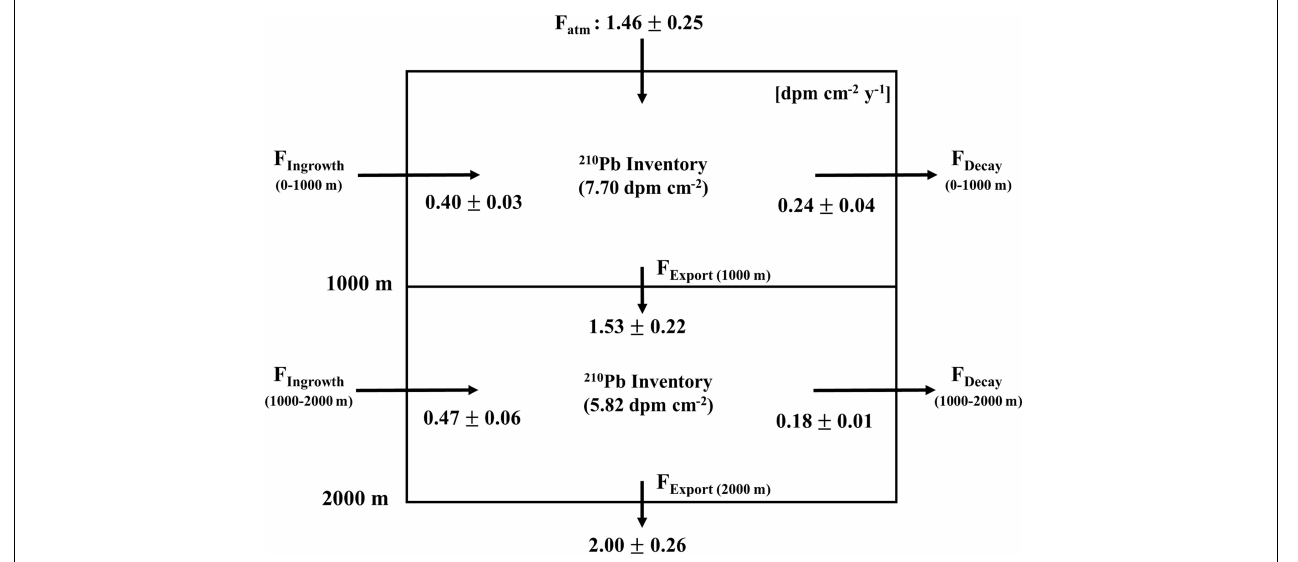
FIGURE 4 | A schematic box model accounting for the ingrowth, decay, export, and atmospheric flux of 210 Pb in the East Sea (dpm cm − 2 y − 1 ). TABLE 1 | Comparison of atmospheric depositional fluxes of 210 Pb (dpm cm − 2 y − 1 ) around the East Sea. Study area Lat.